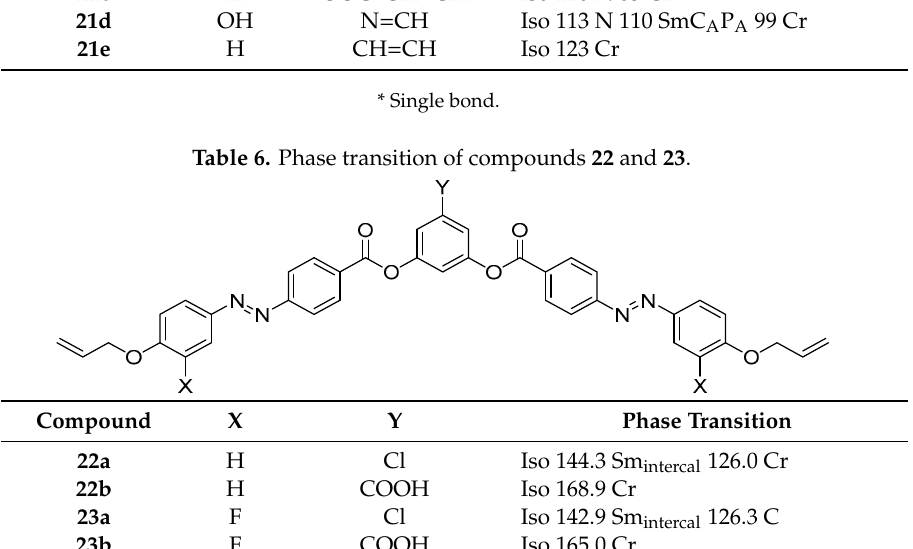
Table 6. Phase transition of compounds 22 and 23 .